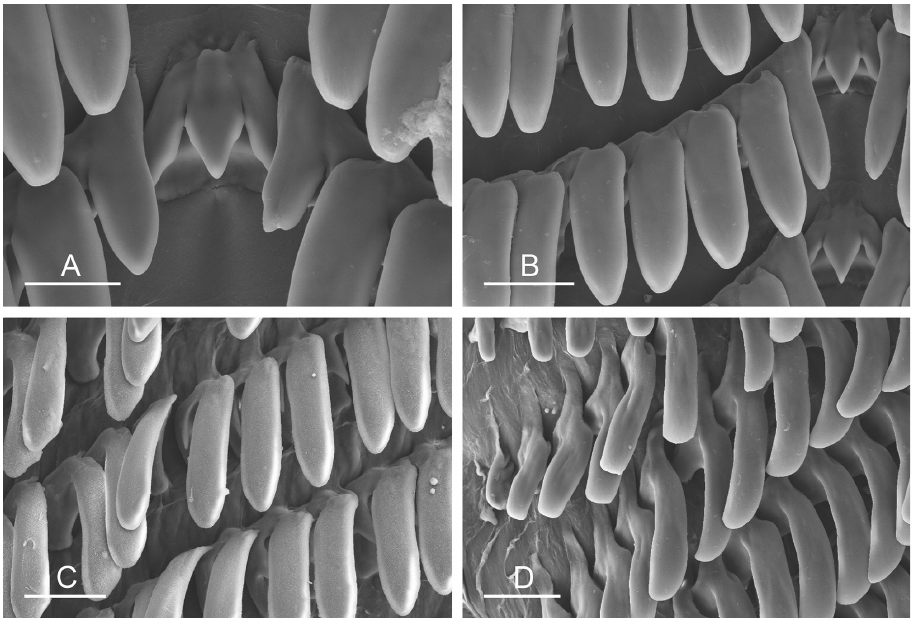
Figure 45. Radula, Wallaconchis graniferum , Philippines. A Rachidian and innermost lateral teeth, Bohol, scale bar 20 μm [3636] (PNM 041228) B Rachidian and innermost lateral teeth, Luzon, scale bar 30 μm [3163] (PNM 041227) C Transition between inner lateral teeth and outer lateral teeth, Bohol, scale bar 30 μm [3635] (PNM 041228) D Outermost lateral teeth, Bohol, scale bar 30 μm [3636] (PNM